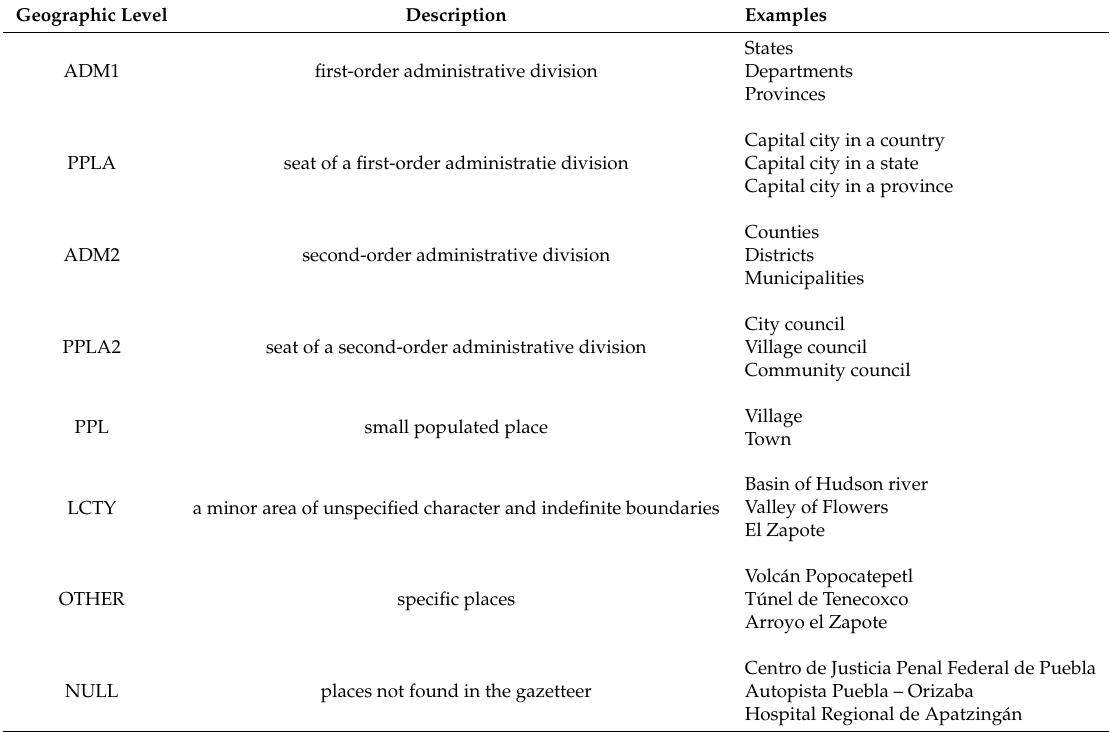
Table A1. Geographic levels based on GeoNames (www.geonames.org/export/codes.html, last access 20 August 2020). We have included the level OTHER to agglomerate those specific places that do not lie within the administrative levels of first, second and third order; we have included NULL to group those places that are not found in the